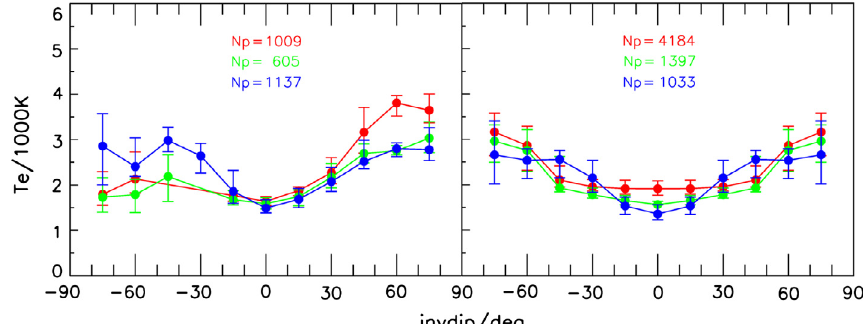
Fig. 5. Equinox (left) and solstice (right) noontime electron temperatures versus invdip latitude at 550 km for three levels of solar activity (blue, low, PF10.7 < 110; green, medium, 110 < PF10.7 < 180; red, high, PF10.7 > 180). Data shown are from satellite in situ measurements giving the median plus upper and lower quartiles. Np is total number of measurements for each curve.